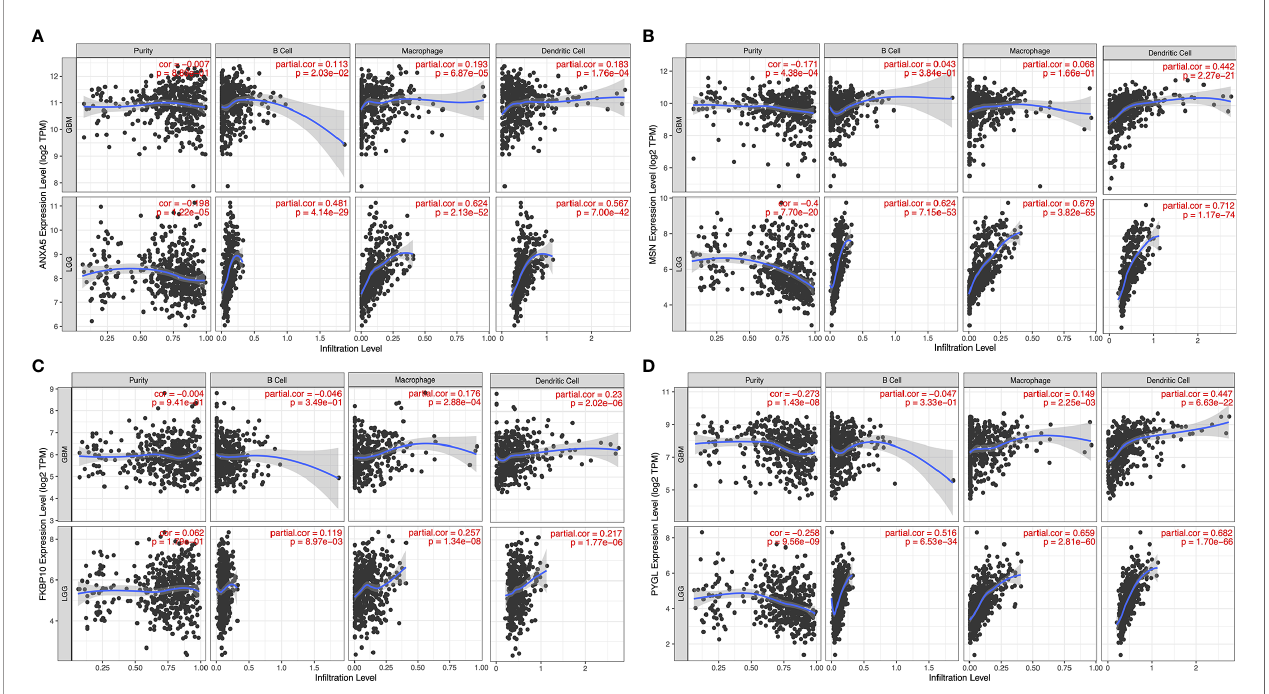
FIGURE 3 | Identi fi cation of tumor antigens associated with APCs. Correlation between the expression levels of ANXA5 (A) , MSN (B) , FKBP10 (C) , and PYGL (D) and in fi ltration of macrophages, dendritic cells, and B cells in GBM and LGG